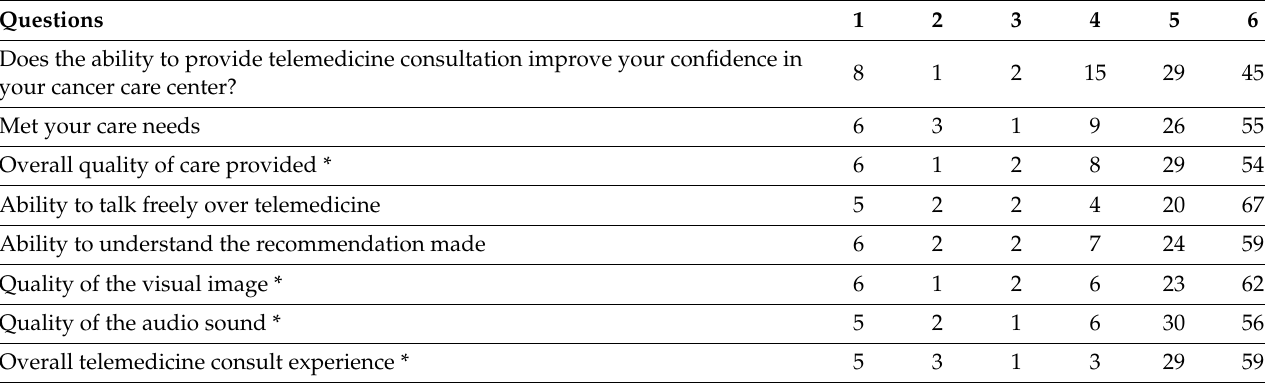
Table 4. Patients’ responses to the survey described in proportion.